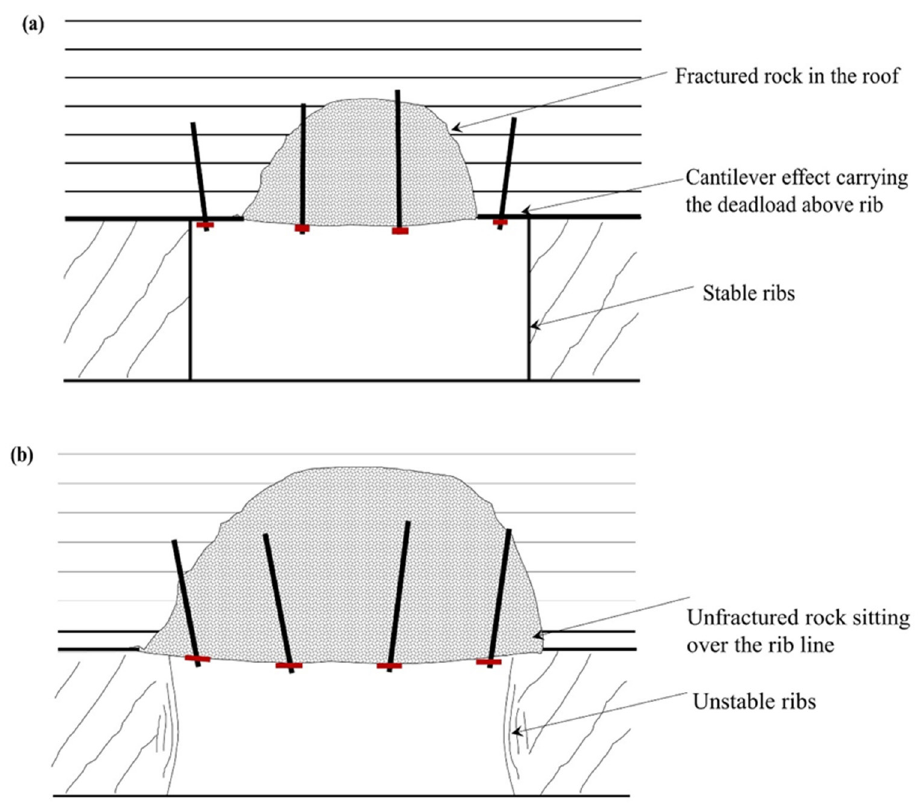
Figure 3. Idealization of the lateral extent of roof fracturing and its impact on rib Loading. ( a ) Un- fractured rib due to cantilever effect in the roof absorbing deadweight. ( b ) Fractured rib: weight of fractured rock absorbed by rib (after [16]).